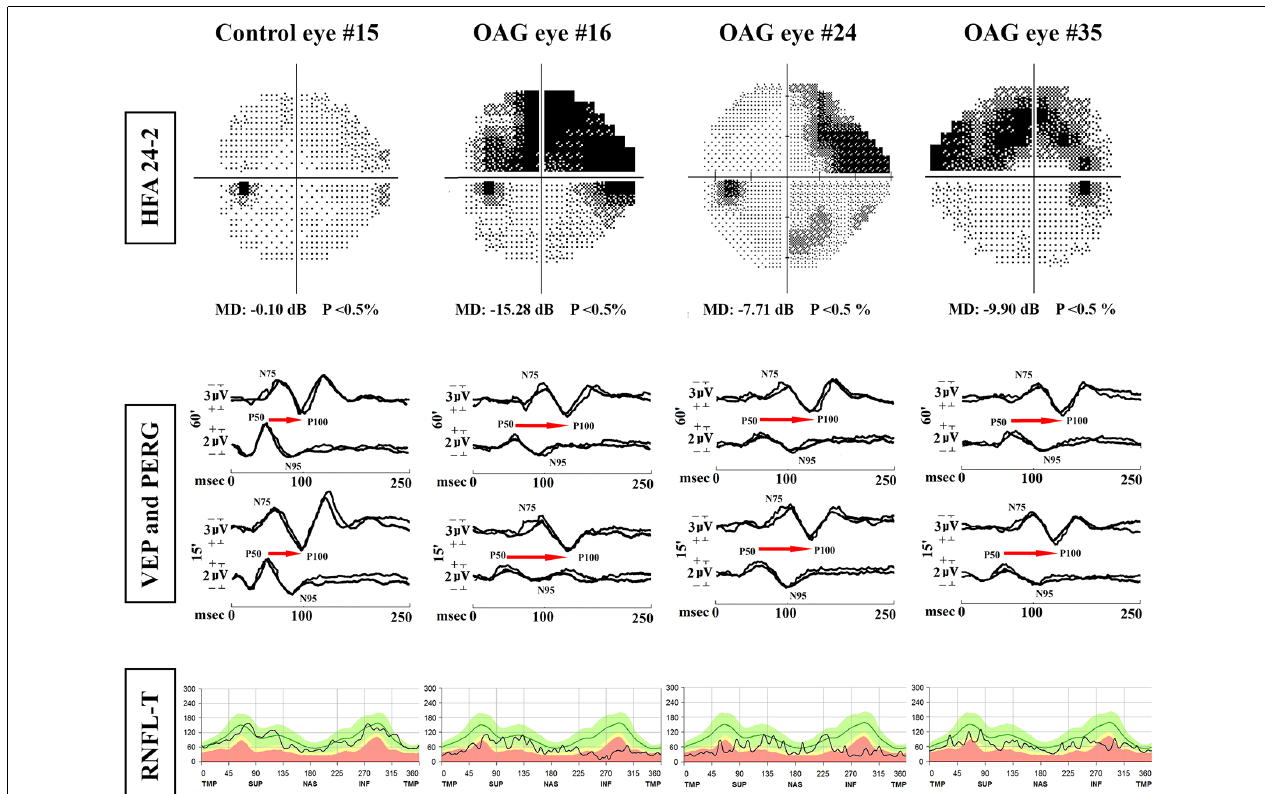
FIGURE 1 | Examples of Humphrey Field Analyzer (HFA) 24-2, simultaneous pattern electroretinogram (PERG) and visual evoked potentials (VEP) recordings and retinal nerve fiber layer thickness (RNFL-T) analysis observed in one representative control eye (#15) and three representative OAG eyes (#16, #24, #35). MD, mean deviation; 60 (cid:48) and 15 (cid:48) , check edges subtending 60 min (60 (cid:48) ) and 15 min (15 (cid:48) ) of the visual angle for PERG and VEP visual stimuli; N75 and P100 refer to the first negative and the first positive peak of VEP recordings (the implicit time of P100 and the peak-to-peak N75-P100 amplitude were considered); P50 and N95 refer to the first positive and the second negative peak of PERG recordings (the implicit time of P50 and the peak-to-peak P50-N95 amplitude were considered); the retinocortical time (RCT), indicated by the red arrow, is the difference between VEP P100 and PERG P50 implicit times. msec, milliseconds; µ V, microvolt; T, temporal; S, superior; N, nasal; I = inferior refer to the RNFL sectorial thickness expressed in microns. In OAG eyes, with respect to the control eye, it is possible to observe reduced P50-N95 PERG and N75-P100 VEP amplitudes, delayed P50 PERG and P100 VEP implicit times, increased RCT, and reduced